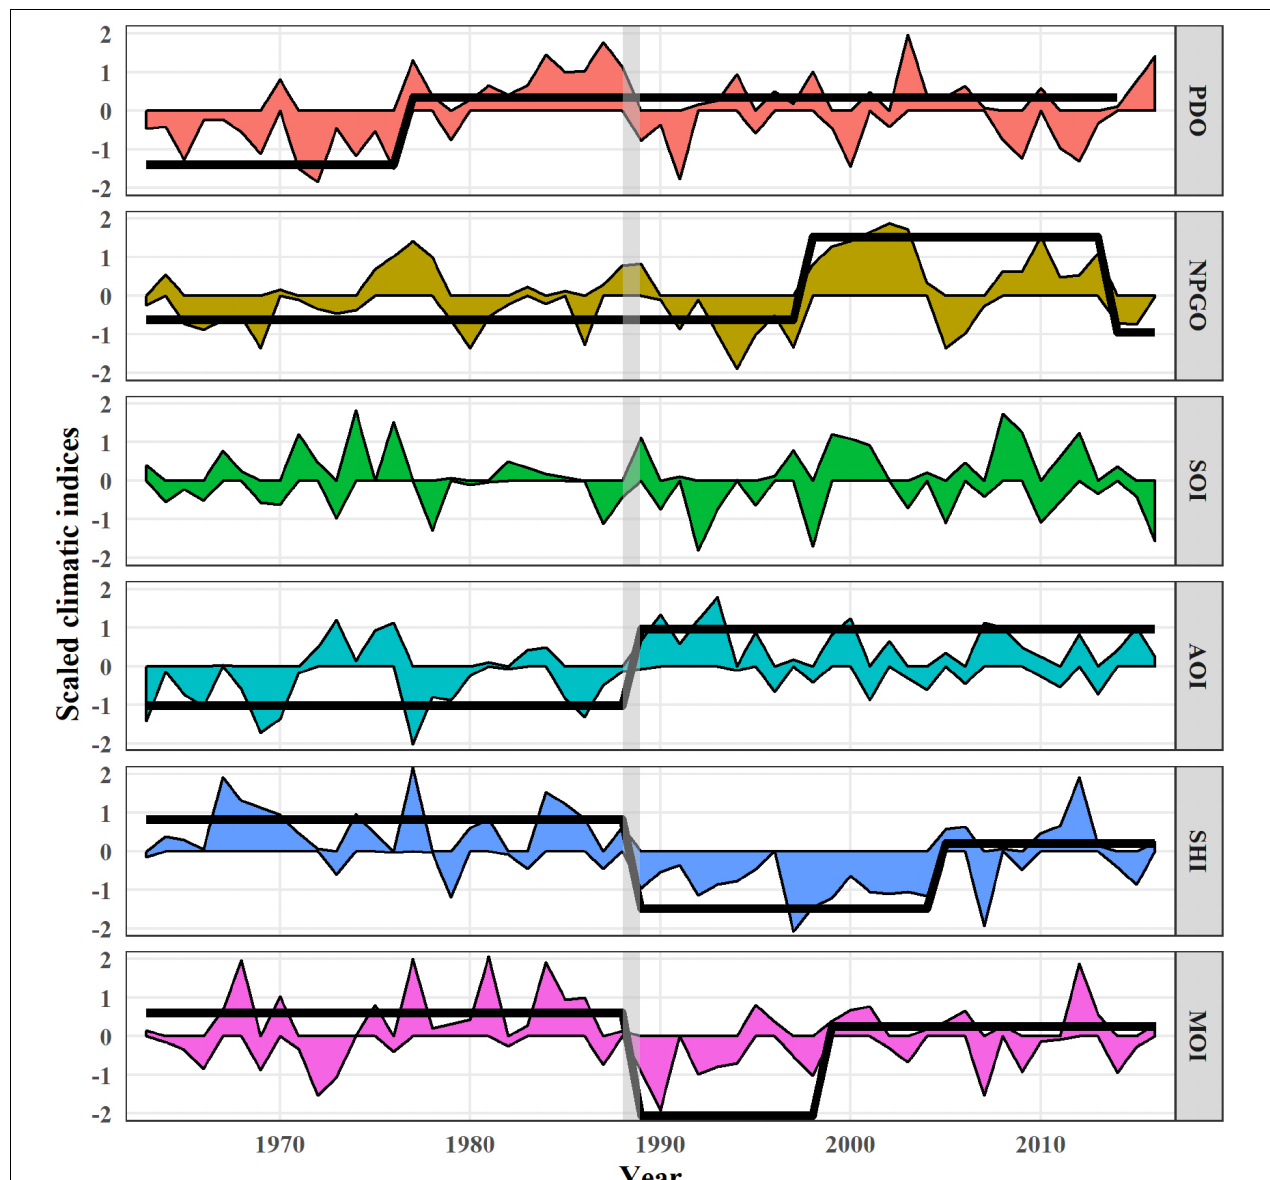
FIGURE 5 | Trajectories of the climatic indices (CIs). Black lines represent regime means calculated by STARS, and gray lines represent the concentrated step-like changes in the late 1980s in contrast to those in Figures 3 , 4 .